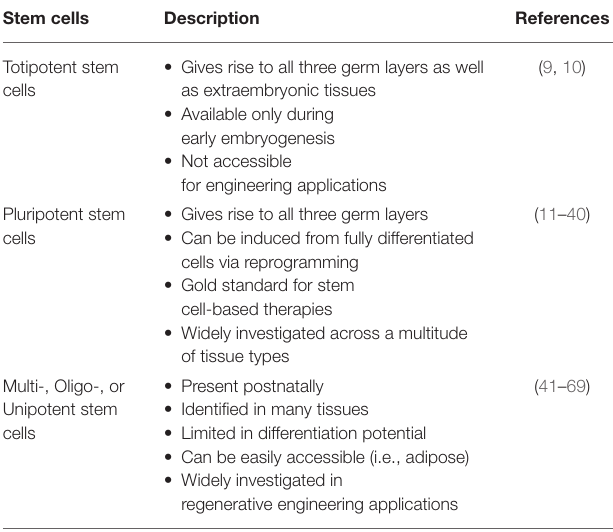
TABLE 1 | Summary of stem